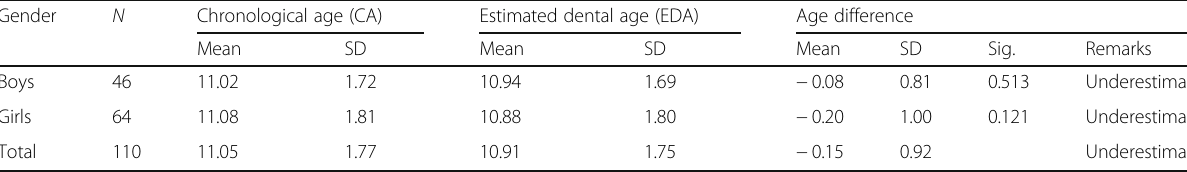
Table 1 Statistical analysis of CA and EDA of the total subjects (in years) Gender